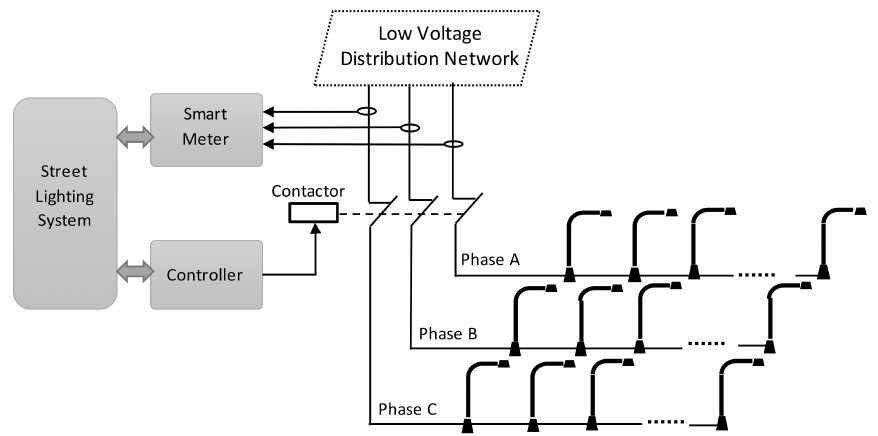
Figure 1. Illustration of power measurements in a street lighting control cabinet.